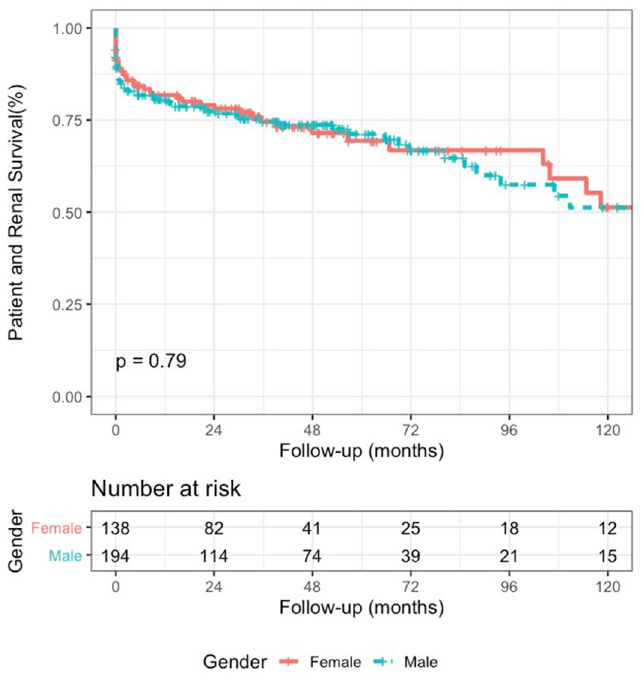
Figure 2. Kaplan–Meier plot demonstrating patient and renal survival in males versus females.